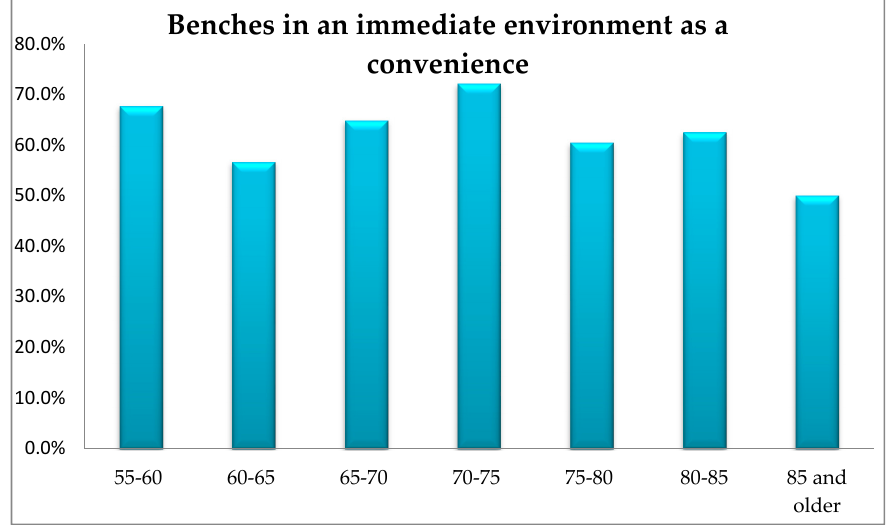
Figure 10. The respondents’ age vs. their opinion about the need of a bench in their immediate environment.